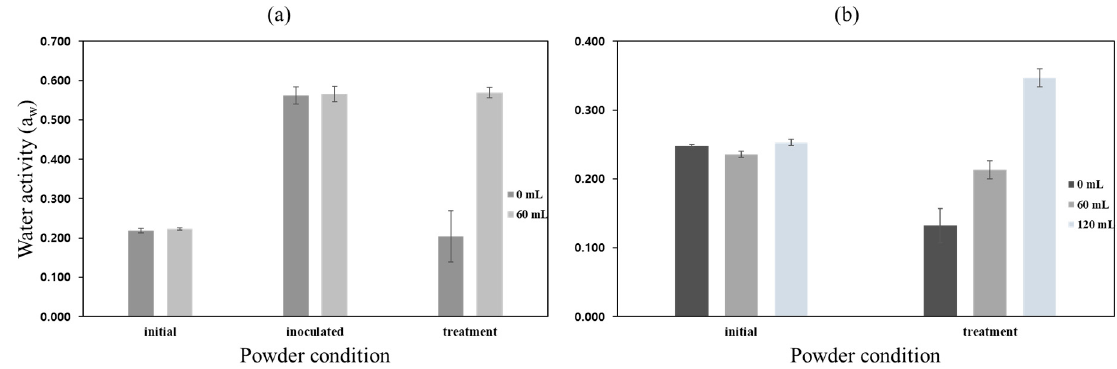
Figure 14. The change of water activity of the ( a ) inoculated and ( b ) un-inoculated powder by vacuum-steam treatments (0, 60, and 120 mL).